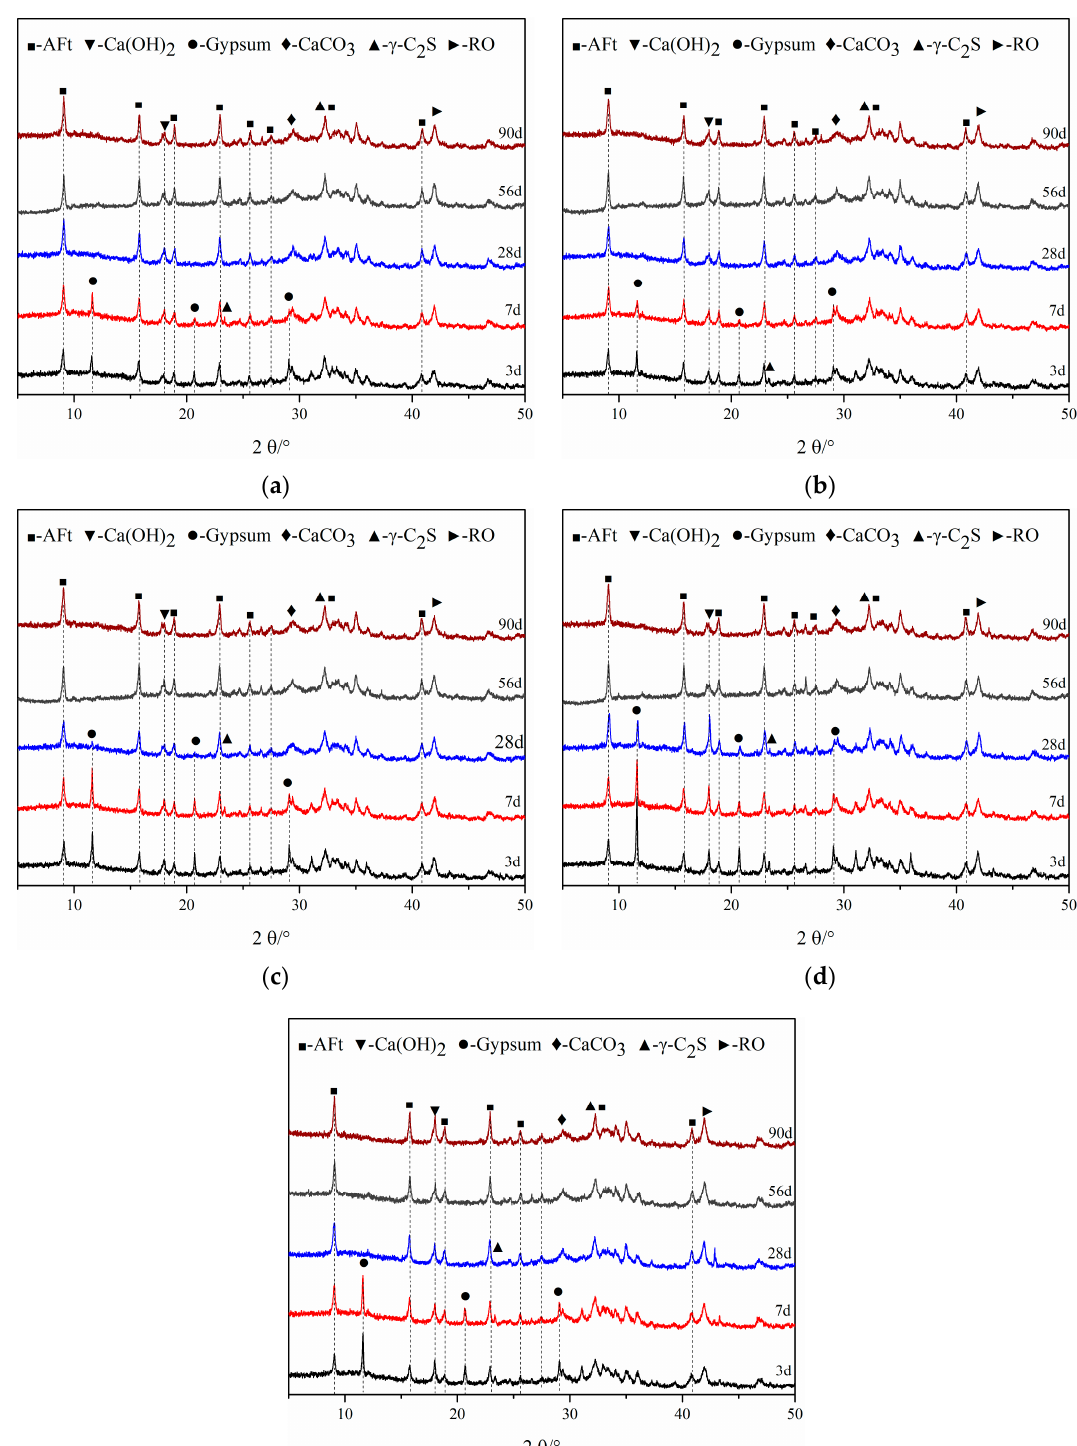
Figure 7. XRD patterns of ( a ) SS40, ( b ) SS43, ( c ) SS40-FA12, ( d ) SS40-FA12 and ( e ) SS50-FA2 at different ages.